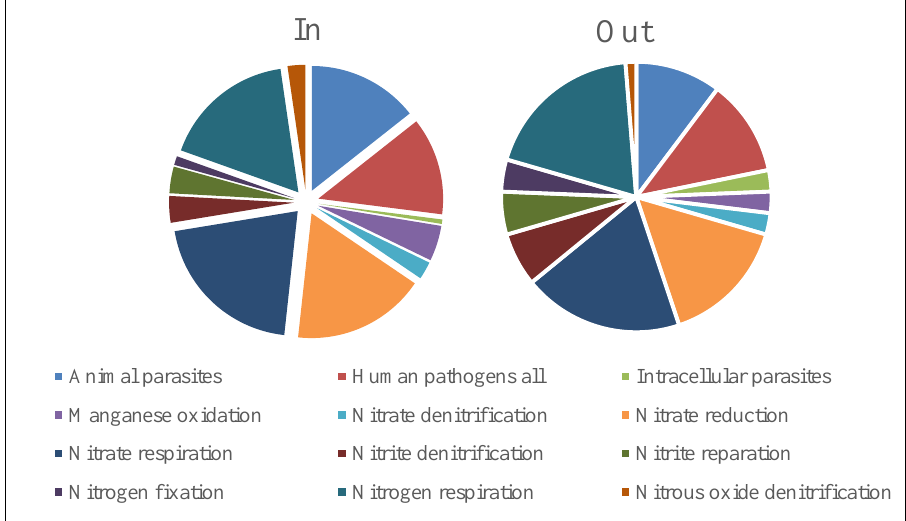
Figure 5. Functionality assignments of the indigenous bacteria during Site B’s